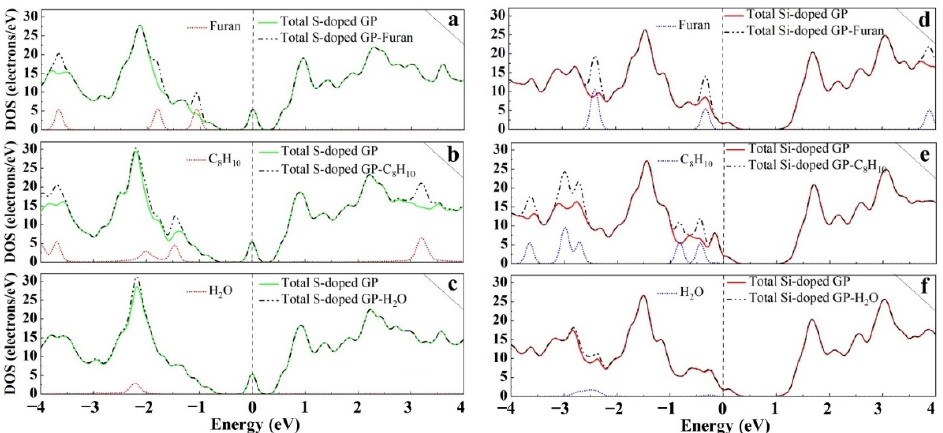
Figure 6. Total DOS curves for S- and Si-doped GP interaction with the molecules. Configurations of S-doped ( a ) furan ( b ) C 8 H 10 ( c ) H 2 O, and Si-doped ( d ) furan ( e ) C 8 H 10 ( f ) H 2 O.